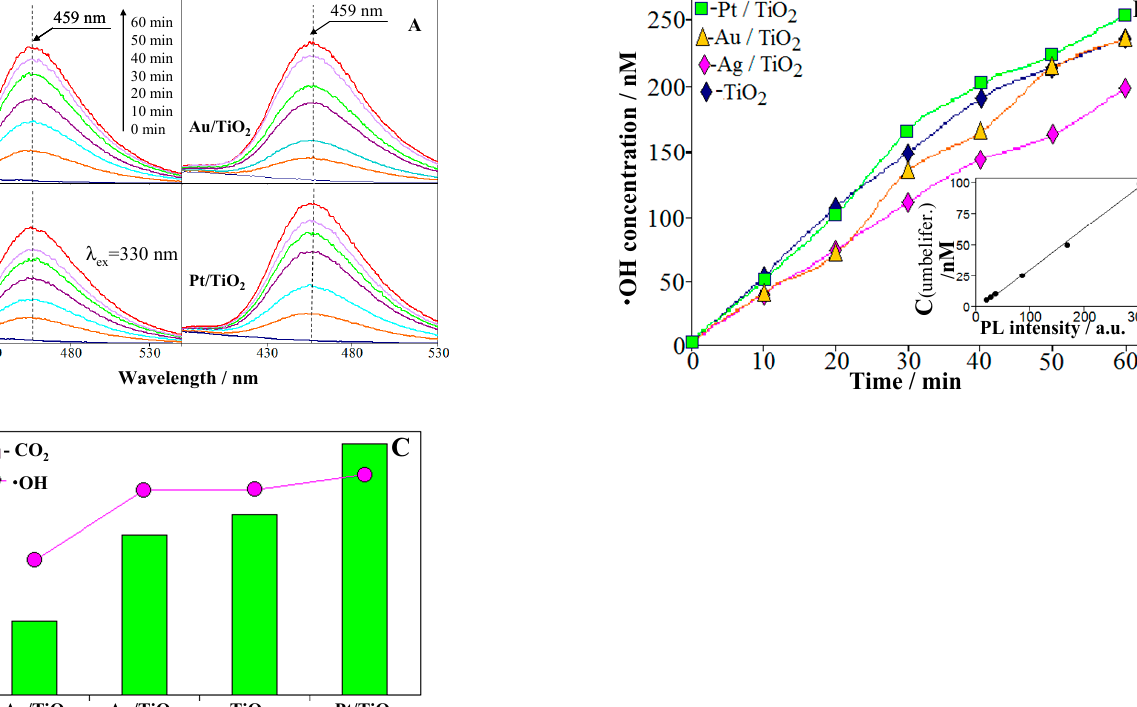
Figure 6. Time course of umbelliferone PL ( A ) and evolution in time of · OH concentration ( B ) over the investigated photocatalysts exposed to solar light, as well as the relative amounts of CO 2 and · OH formed over the photocatalysts exposed to simulated solar light for 6 h ( C ). The formation of · OH radical was evidenced by observing PL peak of umbelliferone at ≈ 450 nm for λ exc = 330 nm (coumarin traps selectively · OH to form umbelliferone). Inset of figure B represents the calibration curve obtained by plotting the PL response against umbelliferone concentration. Experimental conditions: 1 mg catalyst was dispersed by ultrasonication in 40 mL of 11 mM coumarin solution and then exposed to simulated solar light AM 1.5.